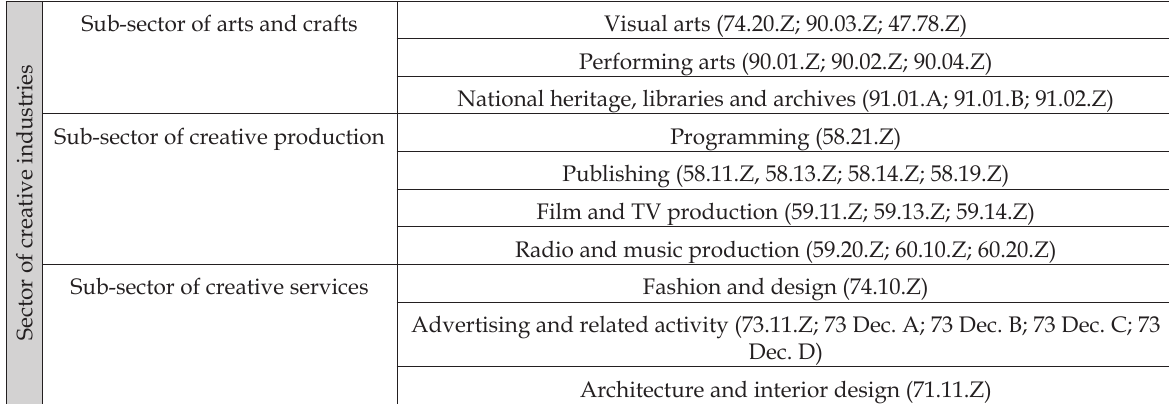
Table 1. Creative industries – division and classification according to PKD 2007 (NaCE Rev.